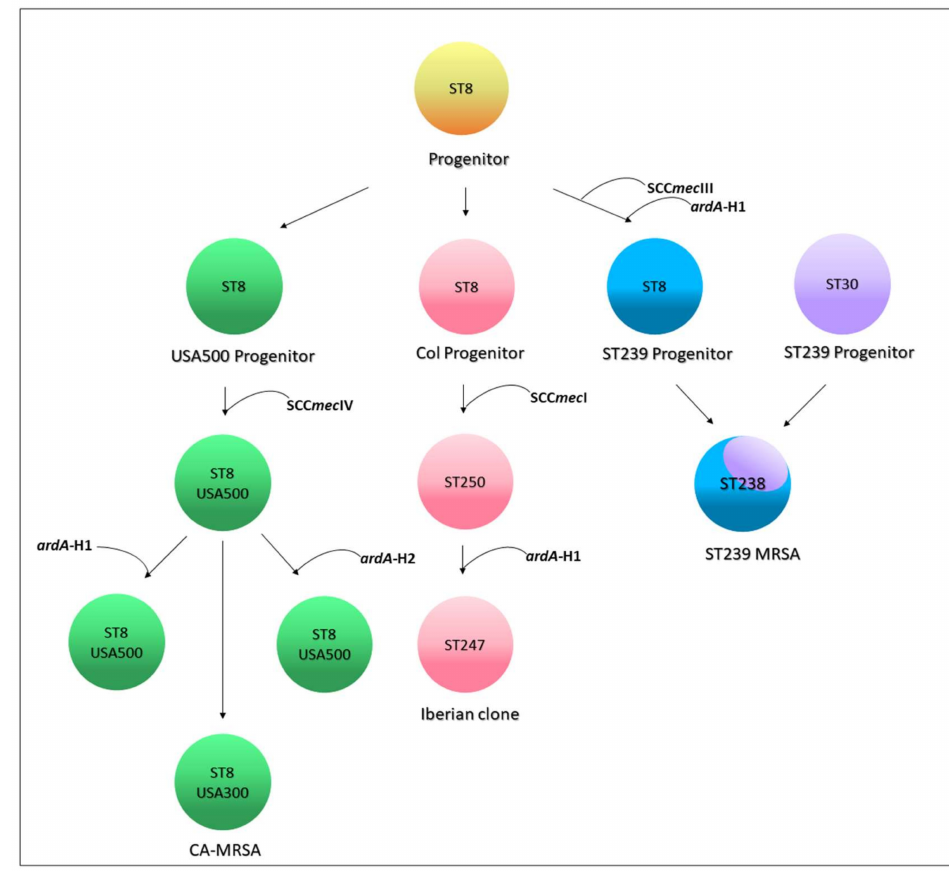
Figure 5. Genetic evolution of ardA- H1 gene in the complex clonal 8 (CC8). Note: unlike USA500 MRSA, the entry of ardA -H1 into the ST239 genome may have occurred prior to ST239 differentiation. ST239 MRSA is a hybrid of the ancestors ST8 and